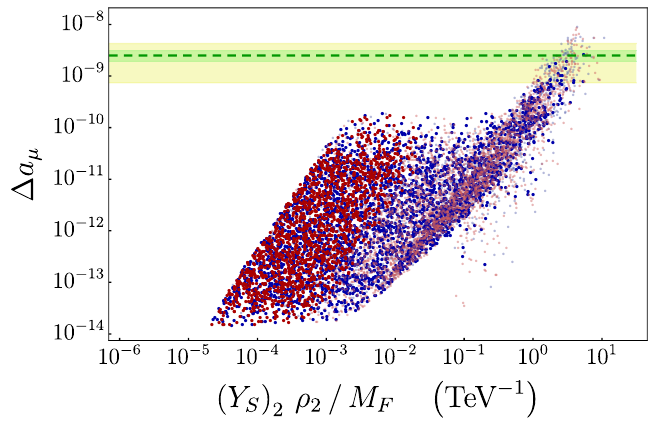
Figure 3 . ∆ a µ as a function of the combination ( Y S ) one or several experimental bounds, but are shown for